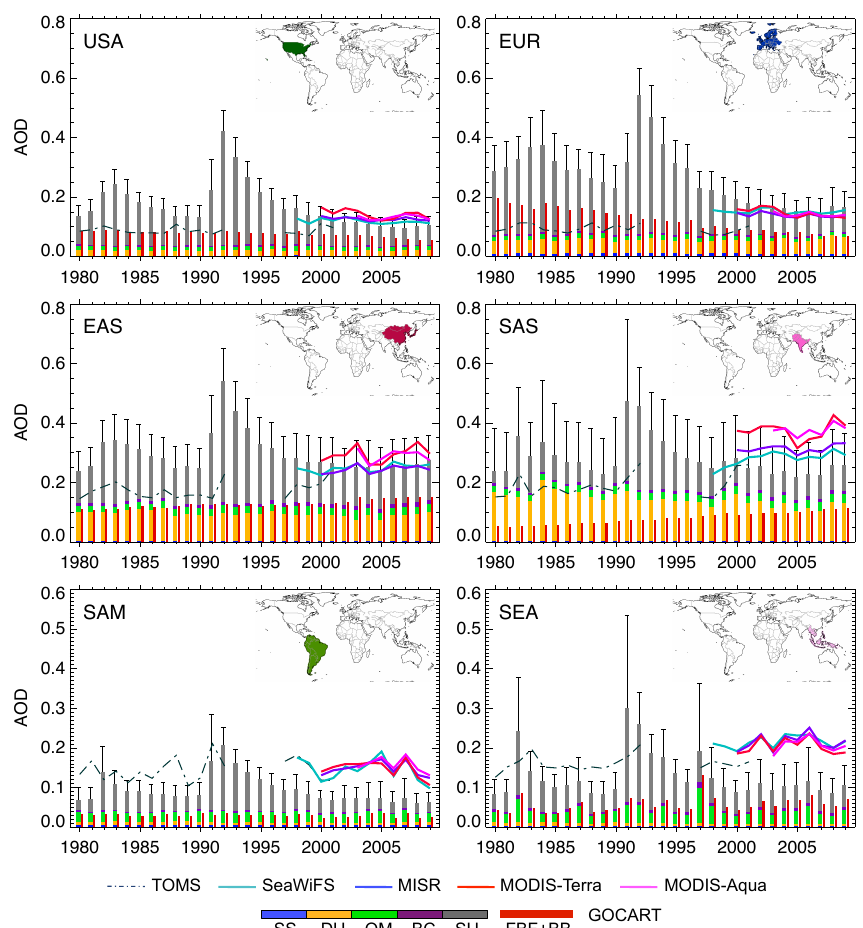
Fig. 6a. Regional annual average AOD from 1980 to 2009 in four pollution source regions of USA, EUR, EAS, and SAS. Region domains are shown in each panel (also in Fig. 1). Satellite retrievals are presented in continuous color lines, and GOCART results are displayed in ver- tically stacked color bars showing AOD composition (SS = sea salt, DU = dust, OM = organic matter, BC = black carbon, and SU = sulfate). AOD from fossil fuel and biomass burning (FF + BB) sources is shown in red vertical lines next to the aerosol composition. All products are averaged within the region domains without considering coincidental spatial/temporal coverage. Note that there is no AVHRR retrieval available over land. Standard deviation of monthly average of regional AOD from GOCART is shown in thin black vertical lines (for clarity, only positive part is plotted and the deviation from satellite data is not